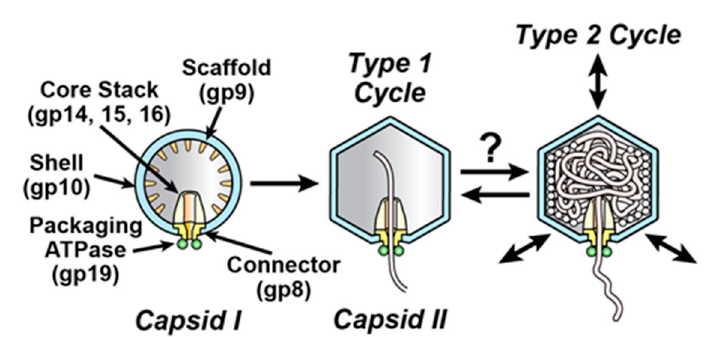
Figure 1. DNA packaging of the related phages, T3 and T7. DNA packaging in vivo is illustrated with capsid II participating in the type 1 and proposed type 2 cycles [2,6]. The connector/portal protein is gene product (gp) 8 ( yellow ); the packaging-promoting, ATP-cleaving enzyme (ATPase) is gp19 ( green circles ); the shell protein is gp10 ( blue ). The gp19 packaging ATPase is assumed to remain on capsid II during packaging, although gp19 has only been detected on capsid I, never on any form of capsid II. The assumption is that capsid II-associated gp19 dissociates from capsid II during capsid purification. The figure is modified from [2].